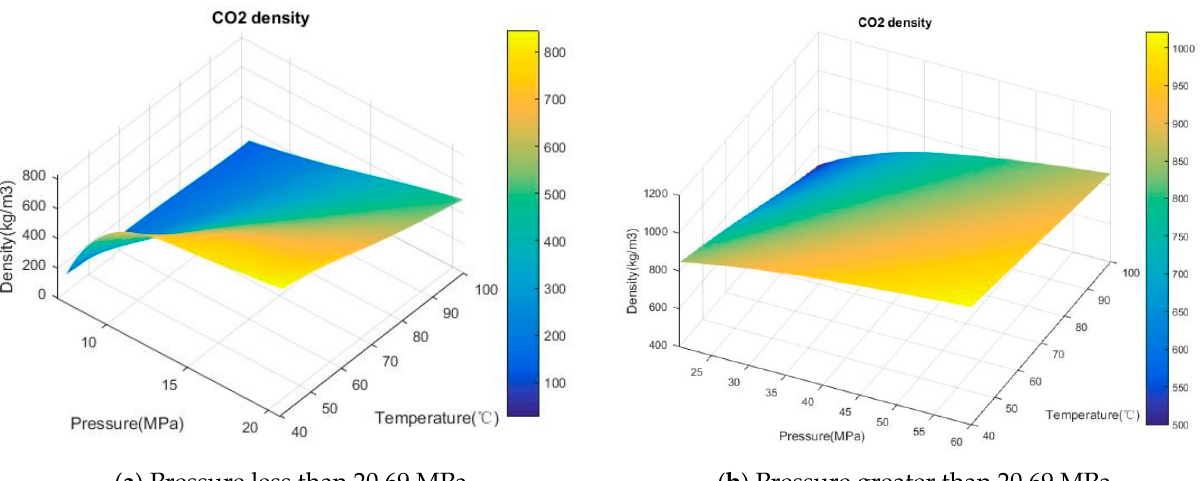
Figure 1. The relationship between SC-CO 2 density and temperature-pressure.